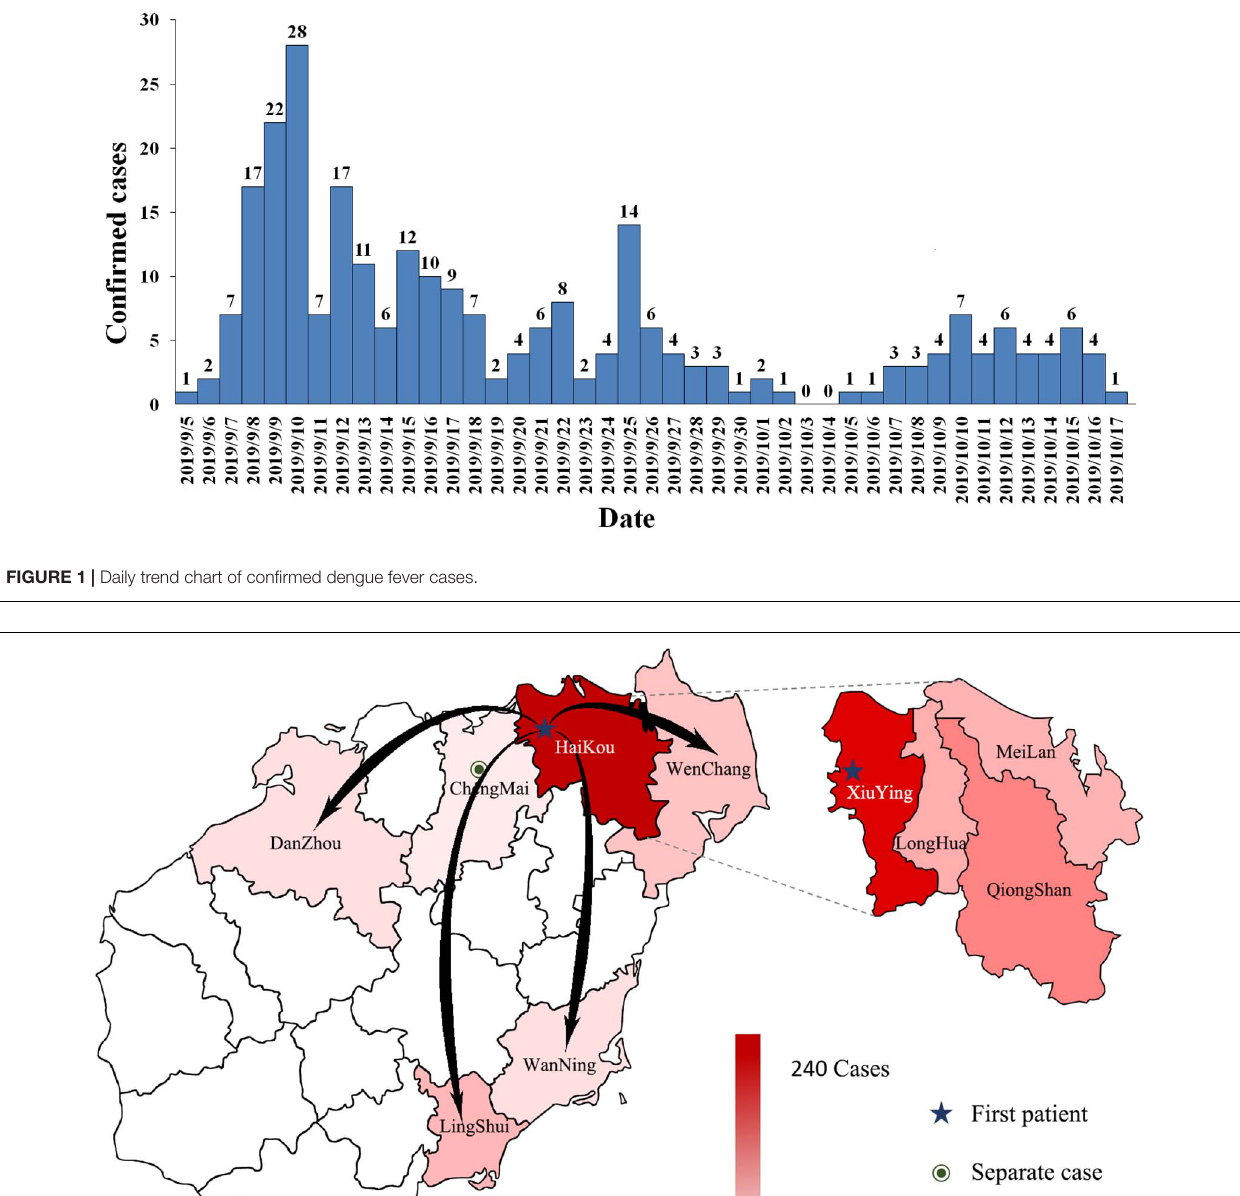
Frontiers in Microbiology |